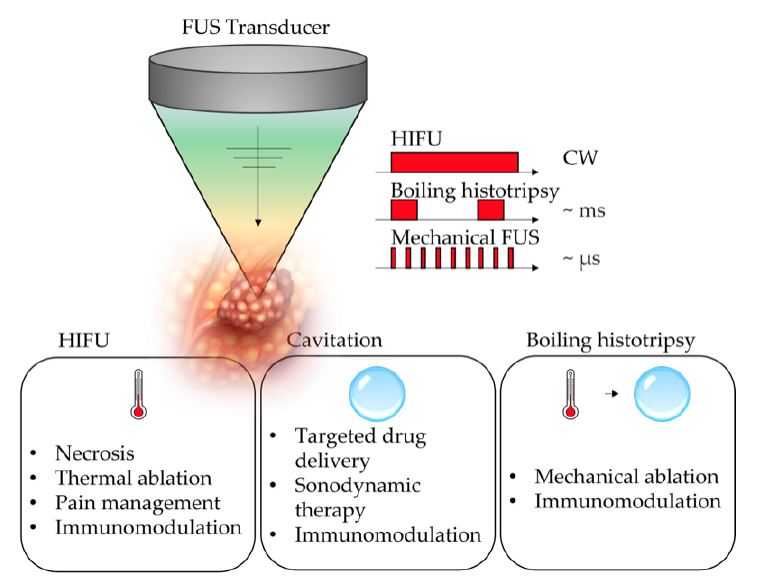
Figure 1. Schematic of the main ultrasound pulsing schemes used in FUS for PDAC treatment and their elicited bioeffects. CW indicates continuous